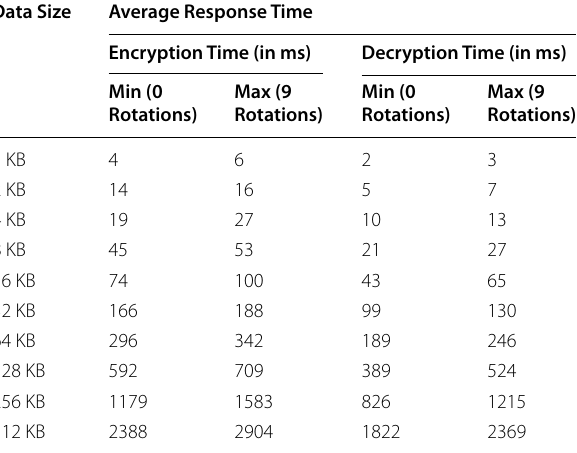
Table 5 Response time for encryption and